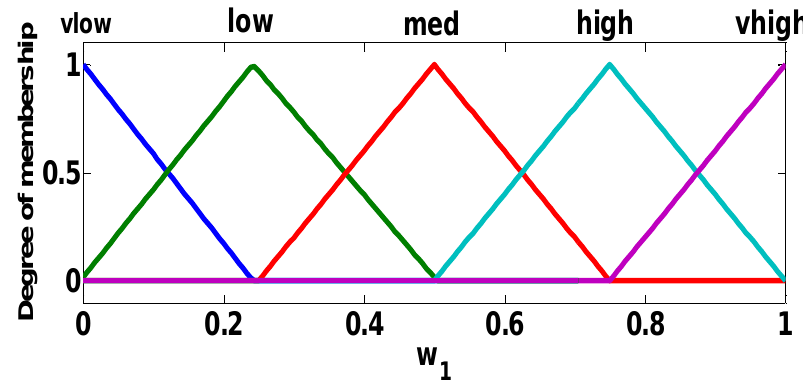
Figure 16. Membership functions for the outputs 𝑤 1 ,𝑤 2 𝑎𝑛𝑑 𝑤 3 .